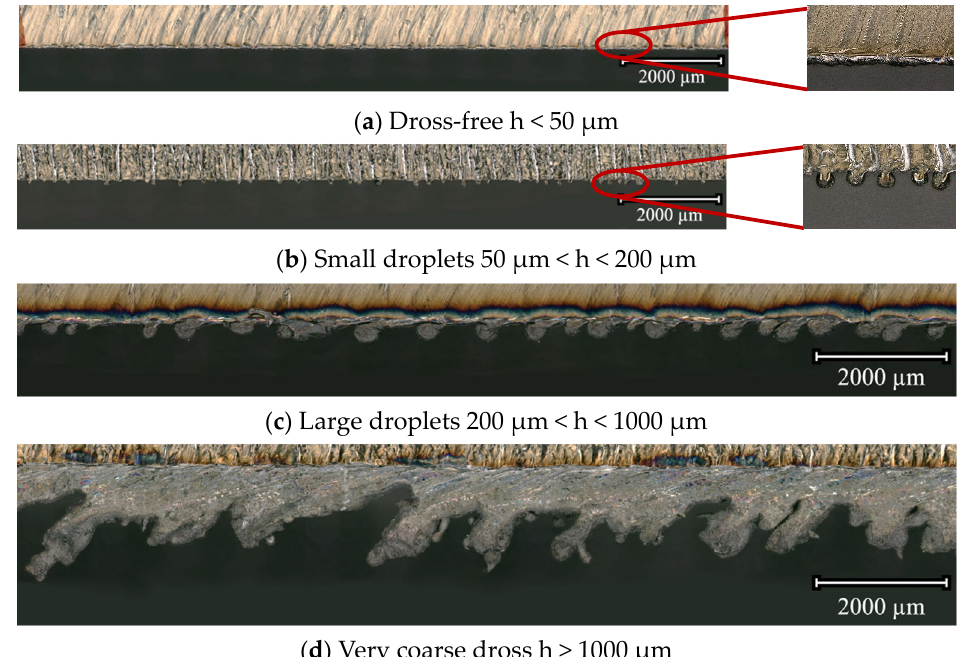
Figure 5. Selected representative dross shapes for the fatigue tests: ( a ) dross-free, ( b ) small droplets, ( c ) large droplets and ( d ) very coarse dross.